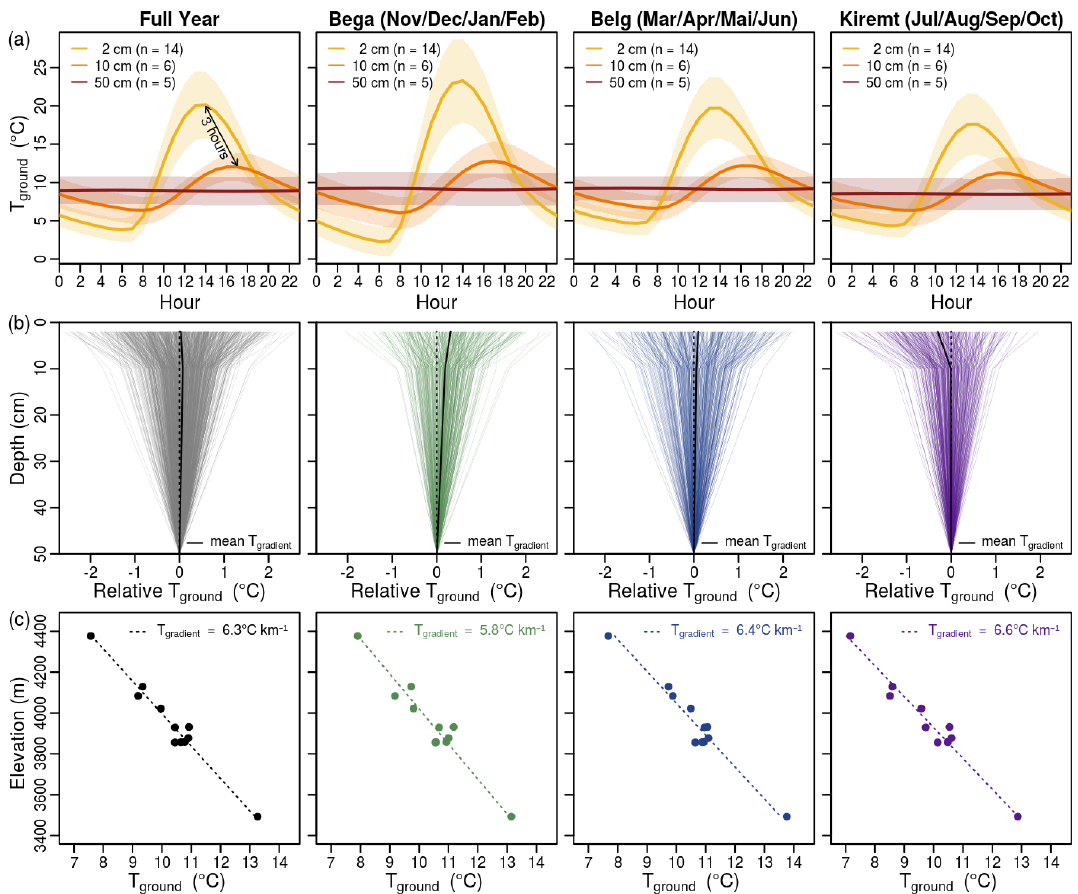
Figure 6. (a) Mean diurnal ground temperature cycle at 2, 10, and 50cm depth averaged over all data loggers from the same depth for the period 1 February 2017 to 20 January 2020 and separately for the dry season (Bega) and two rainy seasons (Belg and Kiremt). The shaded areas display the spectrum (standard deviation) of diurnal ground temperature cycles originating from the different logger locations. (b) Daily ground temperature profiles for the period 1 February 2017 to 20 January 2020. Each line represents a mean daily ground temperature profile averaged over the five locations where data loggers were installed at 2, 10, and 50cm depth. (c) Annual and seasonal ground temperature gradients between 3493 and 4377m for the period 1 February 2017 to 20 January 2020 considering all data loggers installed at 2cm depth (excluding the “cold-biased” GT01t logger from the northern slope of Mount Wasama, the “warm-biased” GT02t logger from the southern slope of Mount Wasama, and the “warm-biased” TM02t logger from the Wasama